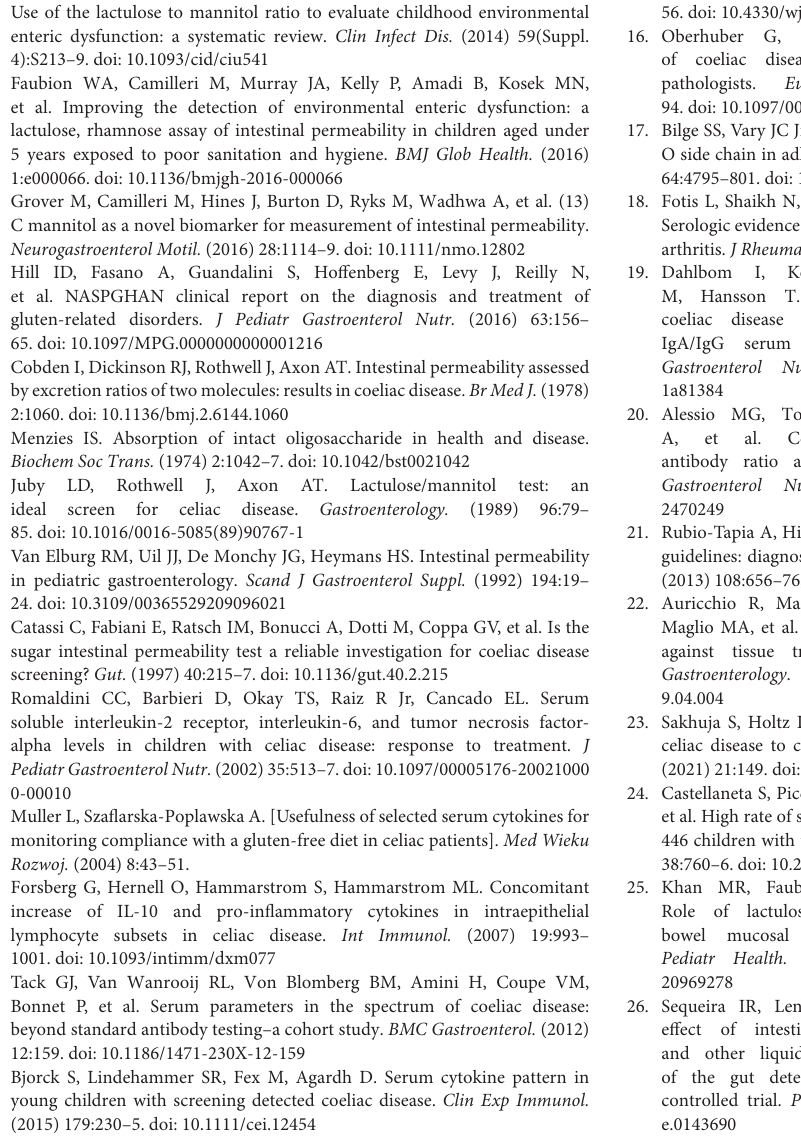
Supplementary Figure 1 | Percent recovery in urine of (A) L in children challenged with L and M and L and R, (B) M in children challenged with L and M, and (C) R in children challenged with L and R. Horizontal lines represent medians and quartiles. Kruskal-Wallis is not significant for all comparisons.